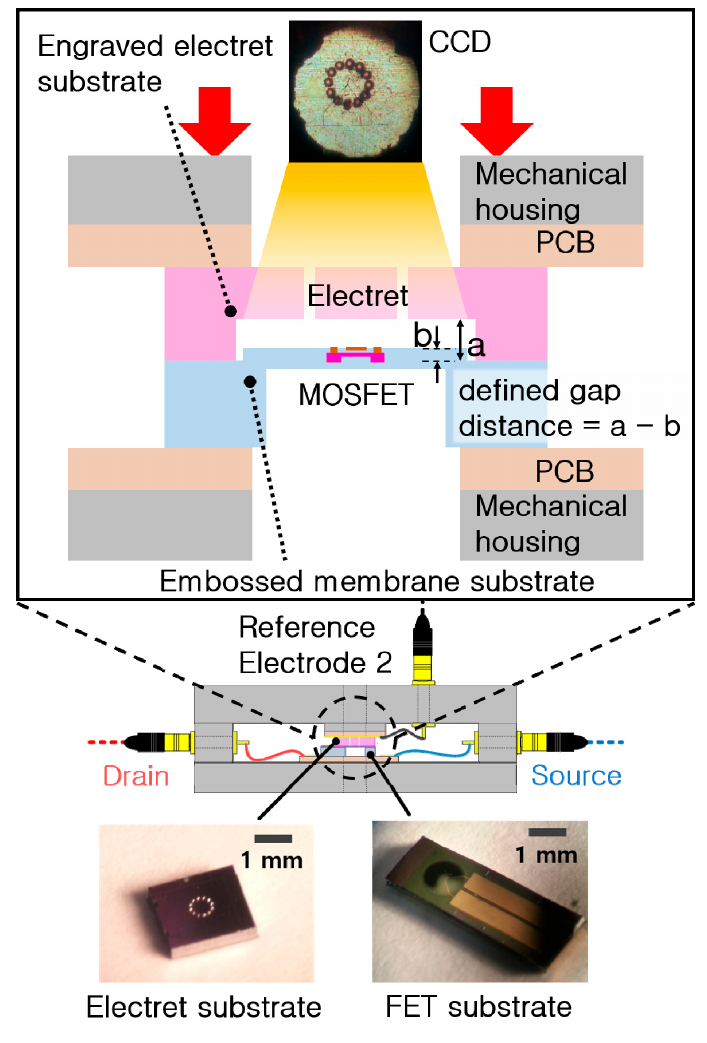
Figure 9. Assembly of the ElGoFET microphone: (upper) brief way to assemble; (middle) schematic diagram of an assembled ElGoFET microphone; (lower) left: electret substrate; right: FET substrate.